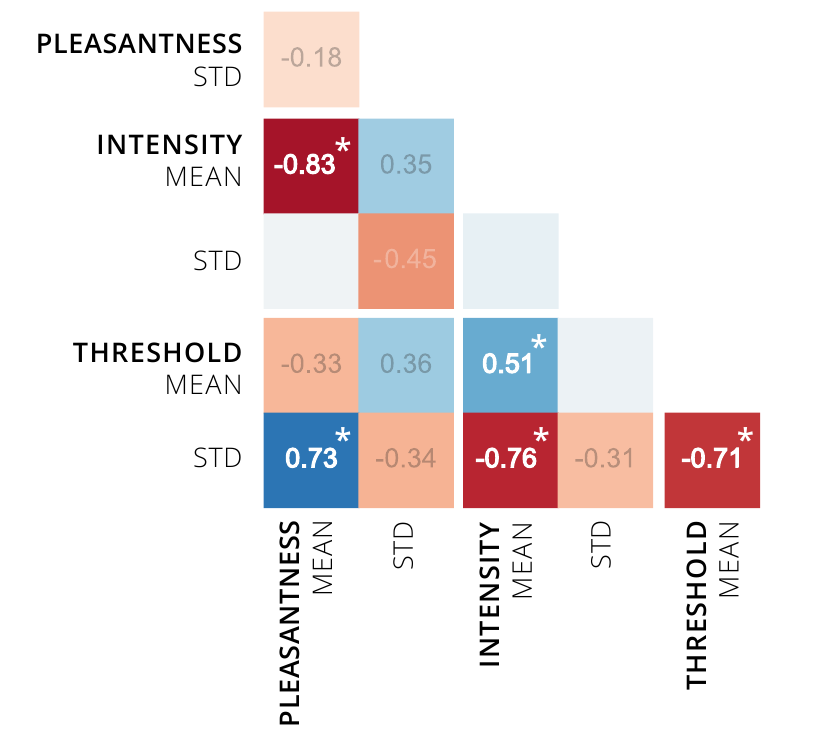
Figure 7. Correlation Matrix of Perceptual Ratings. Pearson correlation coefficients for associations between pleasantness ( n = 13 odor molecules), intensity ( n = 13) and detection threshold ( n = 20). Highlighted in bold and with asterisk are significant correlations to the level of p < 0.05 (two-tailed t -test,